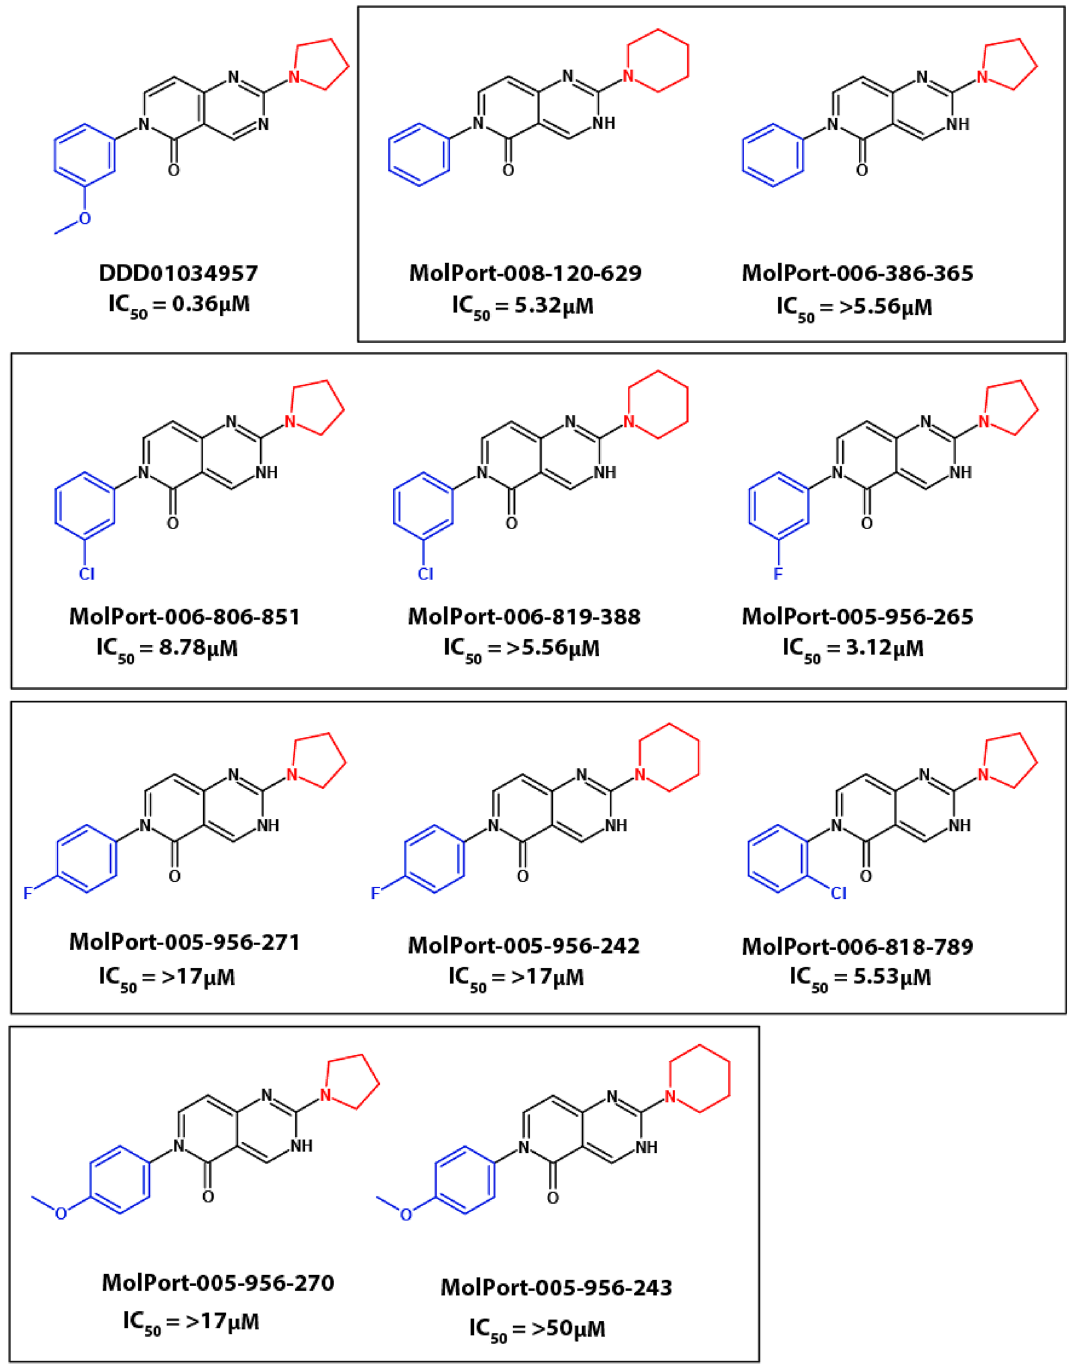
Figure 5. Structure–activity relationship of DDD01034957. Ten commercially available analogues of DDD01034957 were tested for antimalarial activity in the P. falciparum asexual growth assay and efficacy compared to the parent